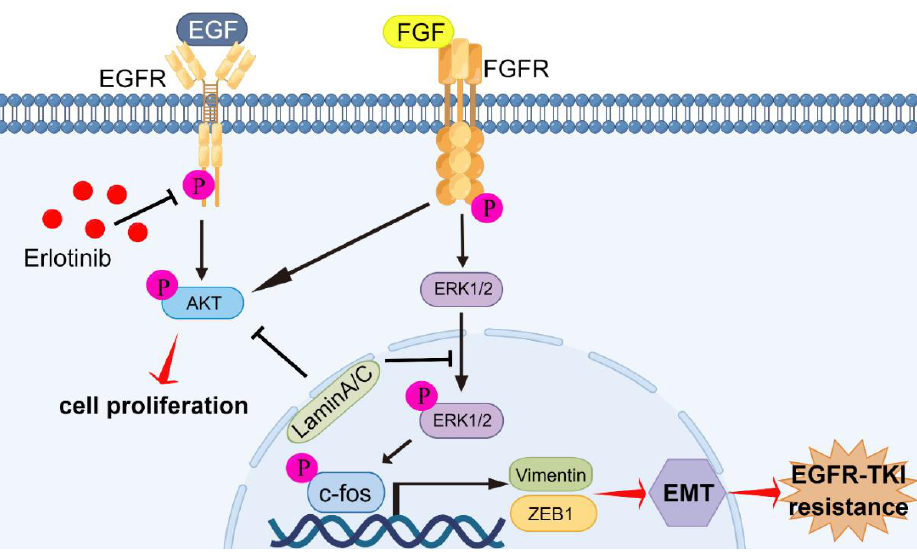
Figure 8. Graphic abstract of molecular mechanisms of laminA/C-regulated EMT promoting acquired resistance to erlotinib in NSCLC. LaminA/C inhibited the phosphorylation of AKT and FGFR to prevent cell proliferation of erlotinib-resistant cells. Meanwhile, laminA/C decreased ERK1/2 and c-fos activation and decreased vimentin and ZEB1 expressions, resulting in reversing of the process of EMT and improving of erlotinib sensitivity in NSCLC with EGFR mutation. By Figdraw (www.figdraw.com).